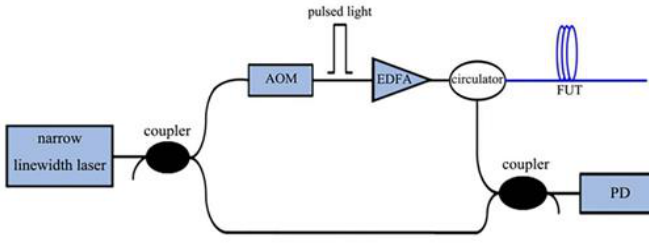
Figure 4. COTDR structure diagram.